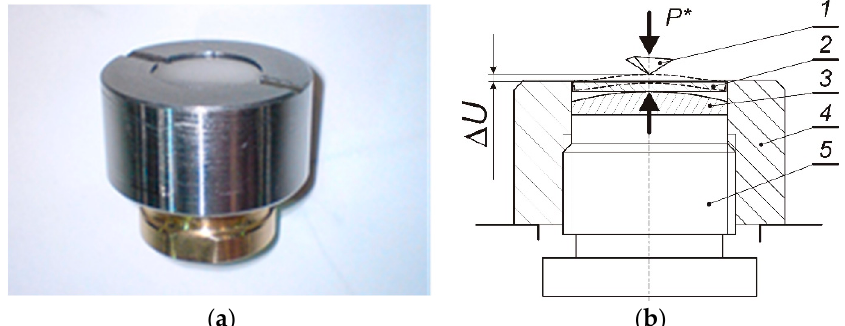
Figure 2. Photograph ( a ) and schematic representation ( b ) of the apparatus for inducing equibiaxial stress at the center of the circular sample subjected to bending, where: 1—tip of indenter, 2—circular sample, 3—spherical element made of bearing steel, 4—screw cap, 5—screw-in pusher, ∆ U—plate deflection at the central point.